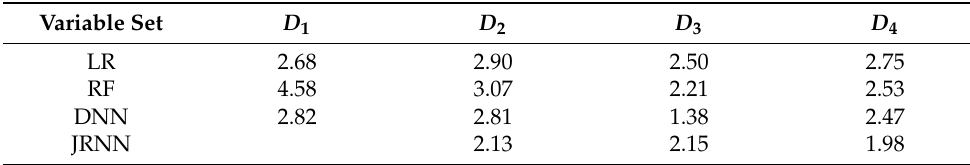
Table 5. Standard deviation of cross-validation overall accuracy (%) across model types and variable sets.